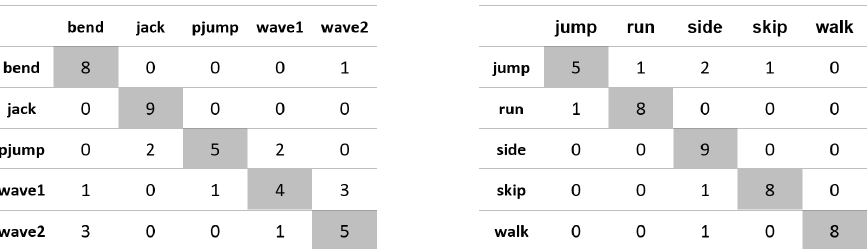
Figure A23. Confusion matrices for the experiment using the ‘upper-occlusion’ database, MBR length and Euclidean distance.